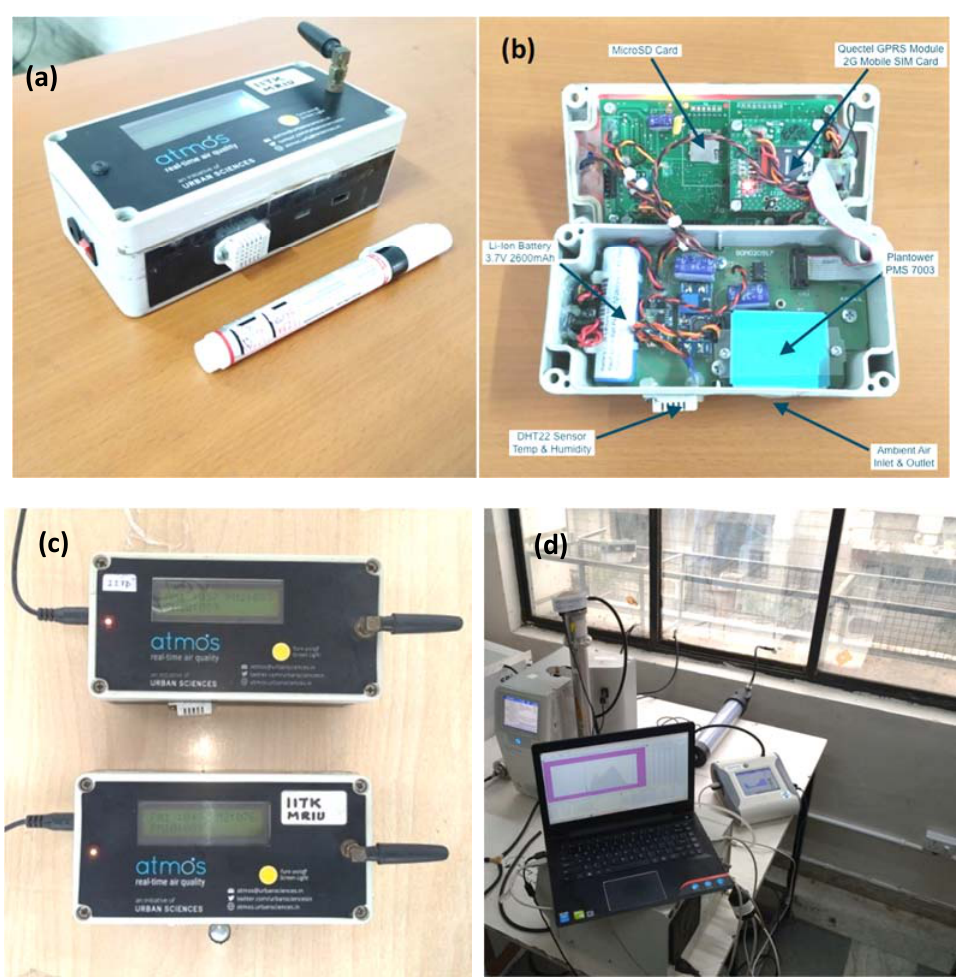
Figure 1. Images from the deployment of low ‐ cost particulate matter (PM) sensors at the study site. ( a ) PM sensor Atmos comparable to the size of a marker pen, ( b ) the PM sensor box housing all components, ( c ) two sensor boxes (used in this study) co ‐ located for consistency test, and ( d ) experimental setup at one of the monitoring sites for ambient air monitoring.